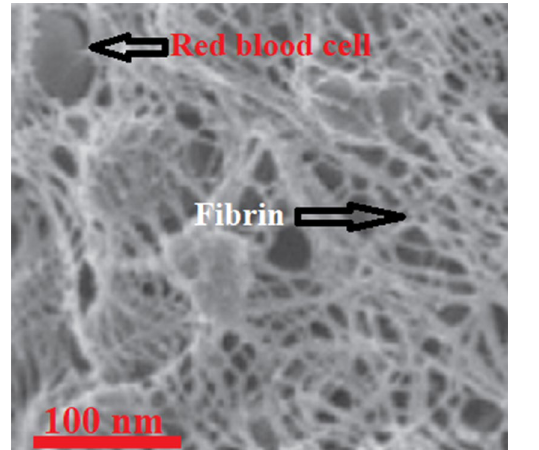
Figure 13. Scanning electron microscope of a blood clot (including red blood cell and fibrin and other elements). Image is at × 5.00 k magnification using a Hitachi Ultra-high-resolution FE-SEM (field Emission Scanning Electron Microscopes). Clots were allowed to form at 37 °C then imaged at room